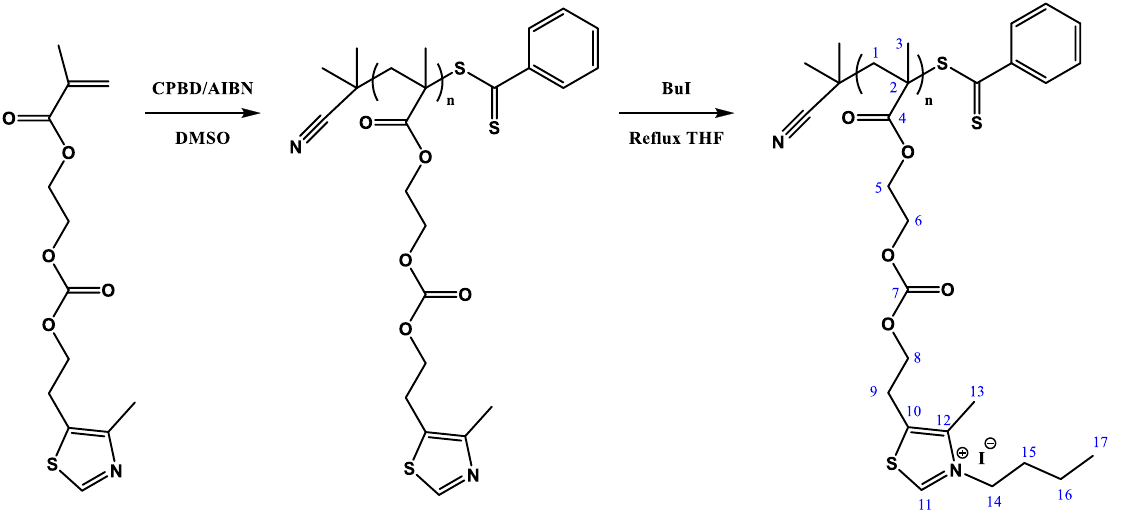
Scheme 4. Synthesis of the cationic polymer